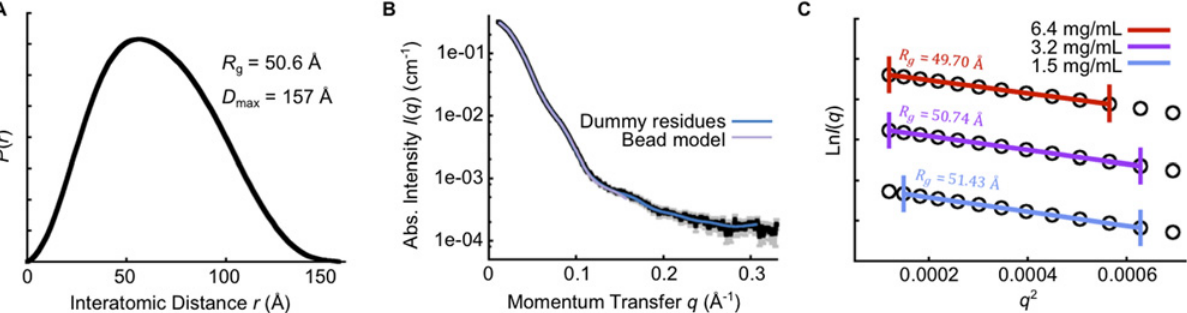
Fig 2. Small-angle X-ray scattering (SAXS) data. ( A ) Pairwise interatomic distance distribution derived from SAXS. The maximum distance ( D max ) from the P ( r ) is 157 Å , and the radius of gyration ( R g ) is 50.6 Å . ( B ) Experimental scattering of wild-type SEN on absolute, logarithmic scale, with 1 σ error bars shown in gray. Theoretical fits of the ab initio models (Fig. 1C) are shown in blue for the dummy residue model, and purple for the cluster-representative bead model. ( C ) Guinier transformation of the data from a concentration series, demonstrating concentration-dependent R g variation of < 5% and linearity over the region q . R g <